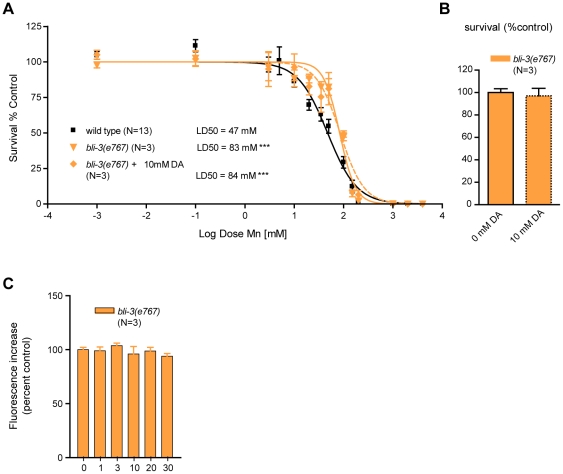

bli-3 loss of function is hyper-resistant to Mn toxicity, insensitive to dopamine pre-treatment, and exhibits no dose-dependent Mn-associated ROS production.(A) bli-3(e767) is hyper-resistant (p<0.001) to Mn-induced lethality, with a LD50 = 83 mM. Pre-treatment with 10 mM dopamine (DA) does not change its hyper-resistance (p<0.001) and its LD50 = 84 mM is not significantly different from animals that were not pre-treated. (B) DA pre-treatment does not affect bli-3(e767) survival at 24 h. (C) Mn exposures from 1 mM up to 30 mM do not affect ROS levels significantly in bli-3(e767) worms (p>0.1). D) bli-3(e767) mutant does not show any significant difference in ROS levels upon Mn exposure up to 30 mM.